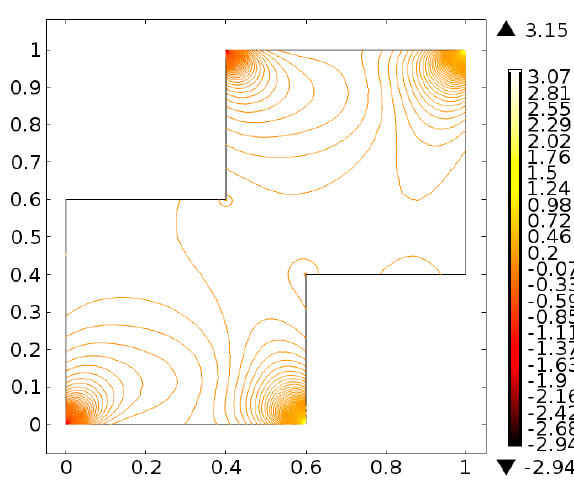
Figure 25. Pressure distribution at Re = 50 for case-II.